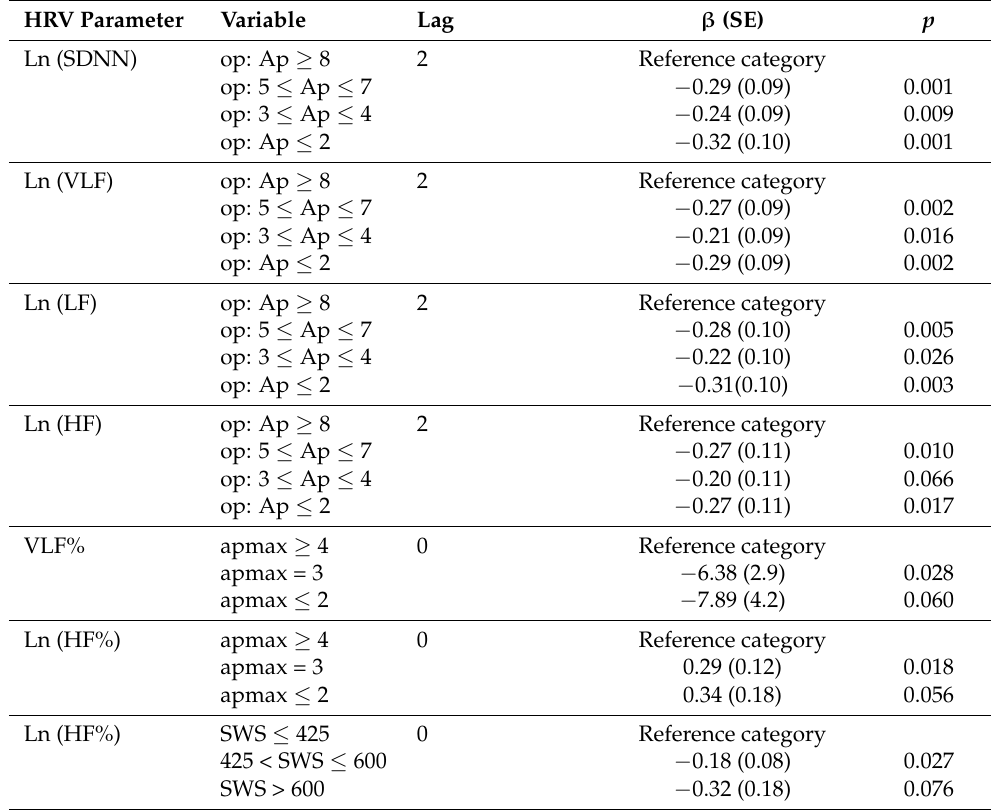
Table 4. Multivariate associations between space weather variables and HRV in graded GMA and SWS categories. HRV Parameter Variable Lag β (SE) p Ln (SDNN) op: Ap ≥ 8 2 Reference category op: 5 ≤ Ap ≤ 7 − 0.29 (0.09) 0.001 op: Ap ≤ 2 − 0.32 (0.10)